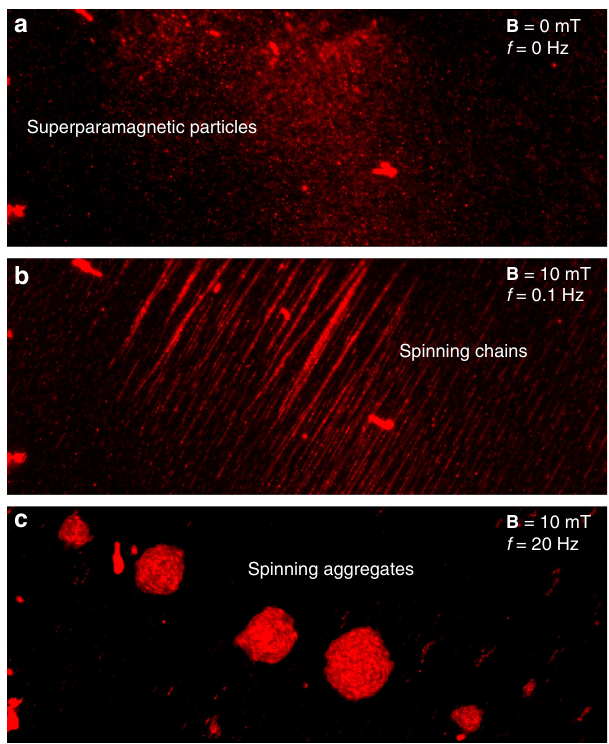
Fig. 4 Particle interaction in a rotating magnetic fi eld. a 1 – 2 µ m fl uorescent superparamagnetic particles are dispersed within the glass slides in the absence of a magnetic fi eld. b The superparamagnetic particles self- assemble and form spinning chains at a rotational frequency of 0.1